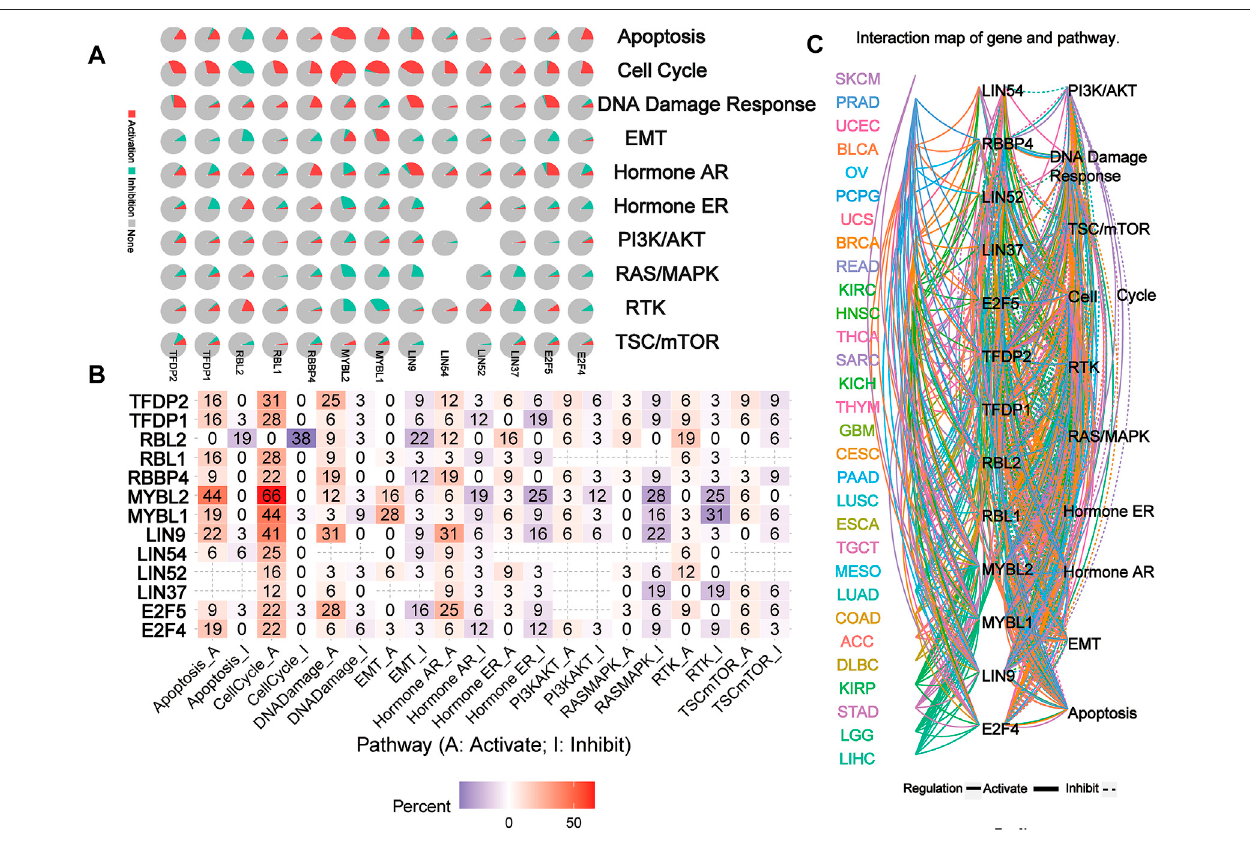
FIGURE 5 | The pathway network between the DREAM complex. (A) The pie chart shows the global percentage of cancers where one gene affects the pathways of 32 cancers. (B) The combined percentage of the DREAM complex ’ s in fl uence on pathway activity. (C) A network showing the relationship between genes and pathways is connected by straight lines. The solid line represents activation and the dashed line represents inhibition. The colors of the lines represent different types of cancer.